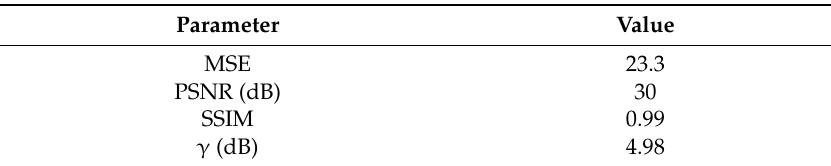
Table 7. Comparison with previous works.